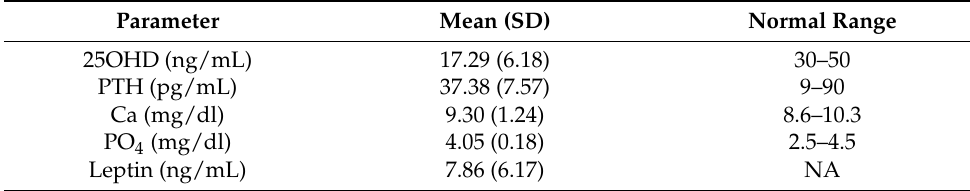
Table 3. Descriptive summary of clinical variables at baseline (n = 75).